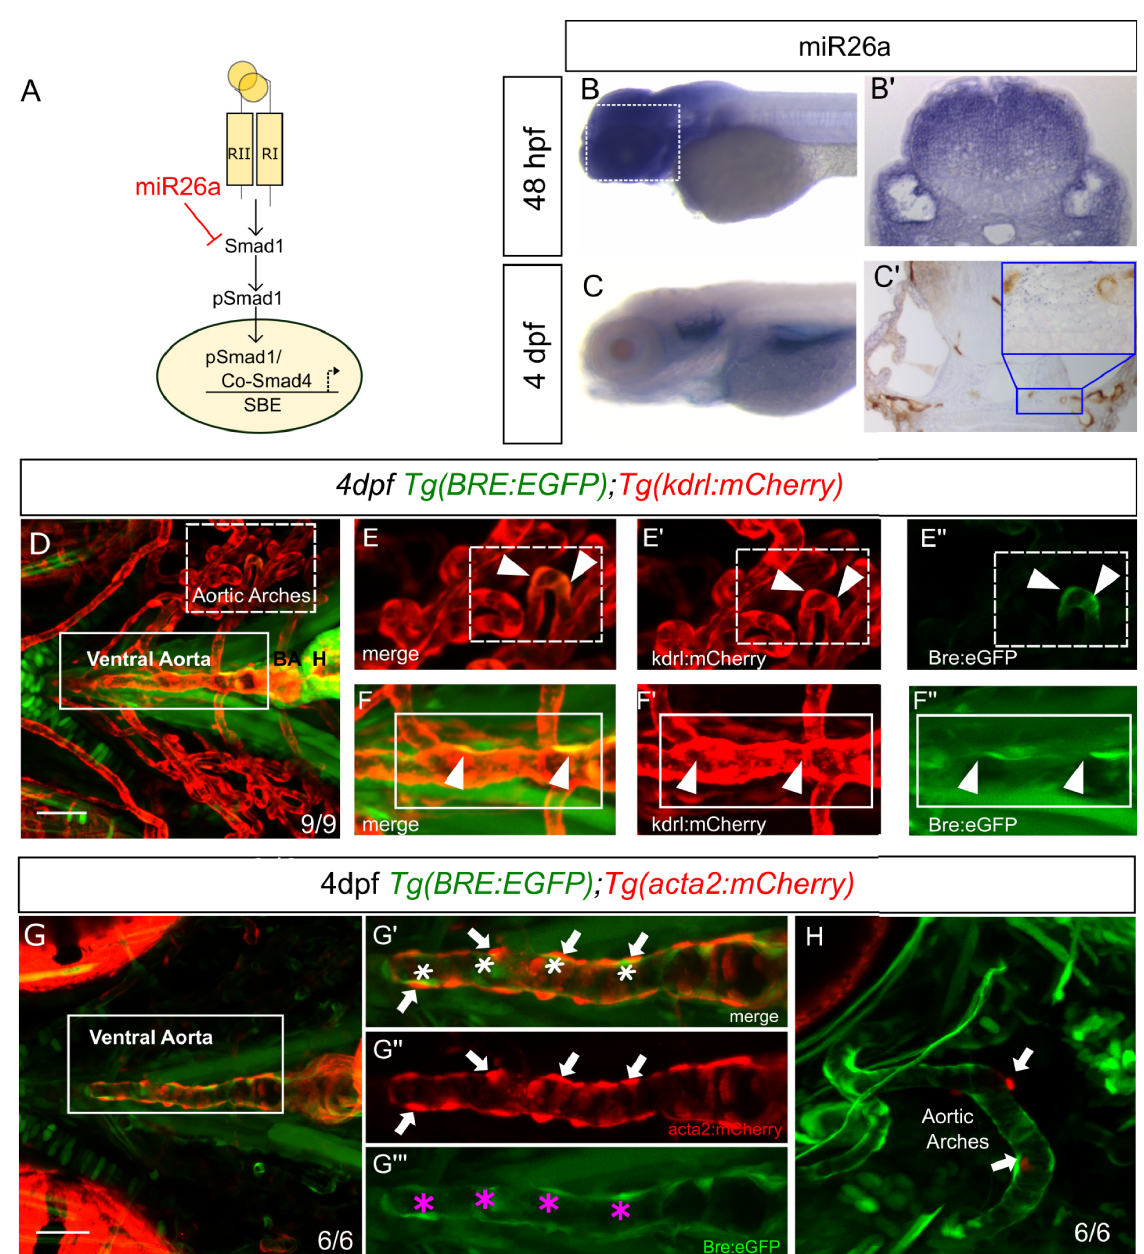
Fig 1. miR26a is expressed in blood vessels; endothelial cells have active BMP signalling. A) Model of how miR26a controls BMP signaling via direct targeting of smad1 . B) Lateral view of whole mount in situ expression of miR26a at 48 hpf shows ubiquitous expression pattern, with strong expression in the ventral head of the embryo. B’) Cross section of the head at 48 hpf. C) At 4 dpf miR26a is expressed in the pharyngeal arches, bulbous arteriosus and ventral aorta. C’) Cross section of the head showing miR26a expression in blood vessels (purple; punctate stain) compared with endothelial stain (brown; kdrl:GFP transgenic). Inset is an enlargement of image in C’. D) Ventral view of the pharyngeal region of a 4 dpf double transgenic Tg(BRE : EGFP);Tg(kdrl : mCherry) embryo shows BRE:EGFP (green) expression within endothelial cells in aortic arches (red, white arrowheads in E’-E”‘) and ventral aorta (red, white arrowheads F’-F”‘). G-H) Ventral and lateral views of a 4 dpf double transgenic Tg(BRE : EGFP); Tg(acta2 : mCherry) zebrafish shows that acta2 positive cells are in direct contact with BMP-responsive endothelial cells but do not express BRE:EGFP. Scale bar represents 50 μ m.